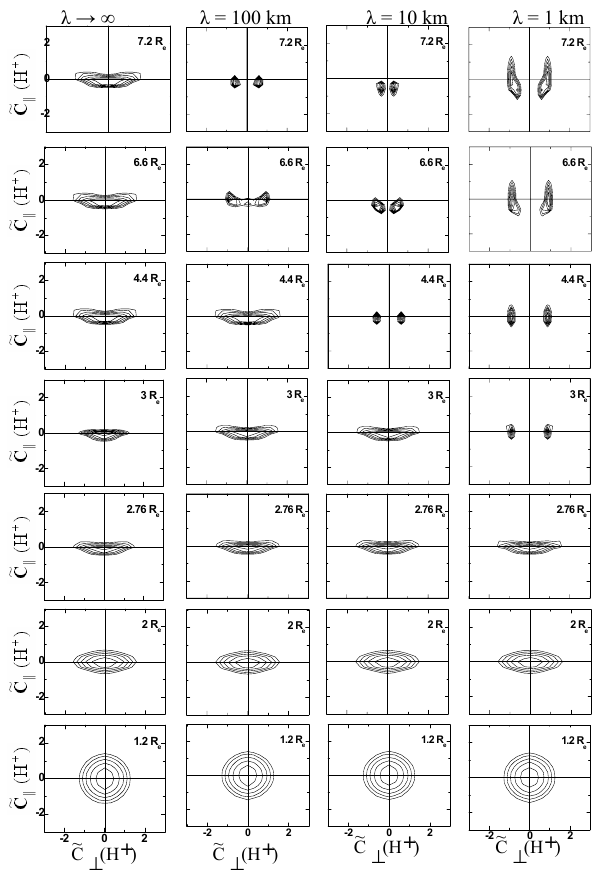
Fig. 3. H + ions velocity distribution functions at differ- ent geocentric altitudes (1.2, 2.0, 2.76, 3.0, 4.4, 6.6, and 7.2 R E ) for different electromagnetic turbulence wavelengths ( λ ⊥ ) , the wavelengths considered here are λ ⊥ →∞ , λ ⊥ = 100km, λ ⊥ = 10km, and λ ⊥ = 1km. f (cid:0) H + (cid:1) is represented by equal val- ues contours in the normalized velocity ( ˜ c k , ˜ c ⊥ ) plane, where ˜ c = (cid:2) v − u( H + ) (cid:3)(cid:14)(cid:2) 2 kT (cid:0) H + (cid:1)(cid:14) m (cid:0) H + (cid:1)(cid:3) 1 / 2 . The contour levels de- crease successively by a factor e 1 / 2 from the maximum.